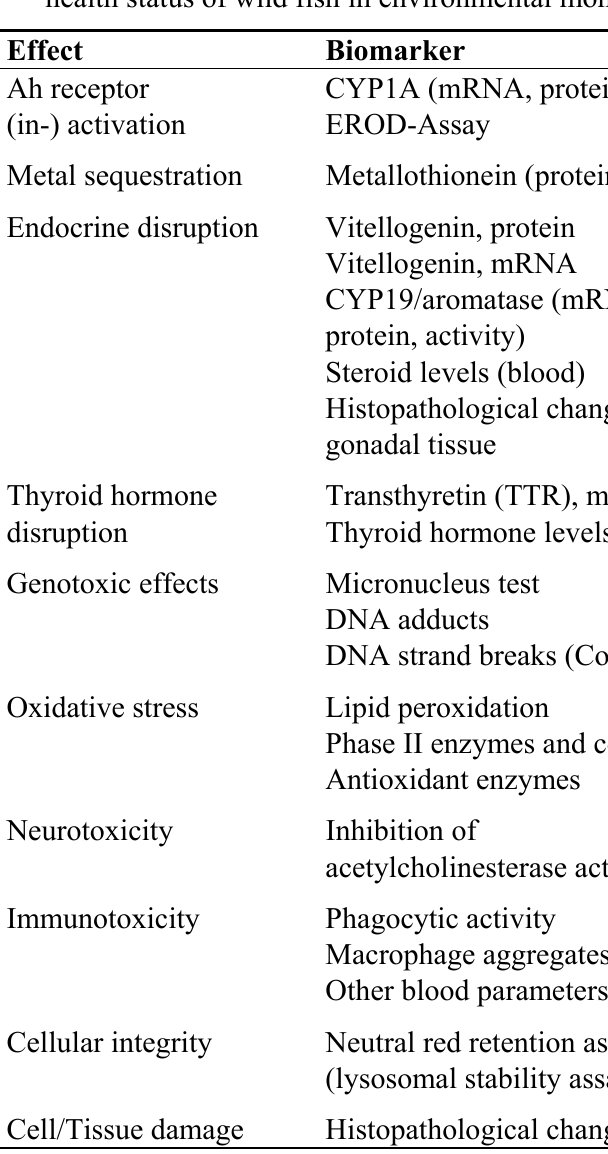
Table 4. Examples of promising biomarkers used to assess exposure to chemicals, and health status of wild fish in environmental